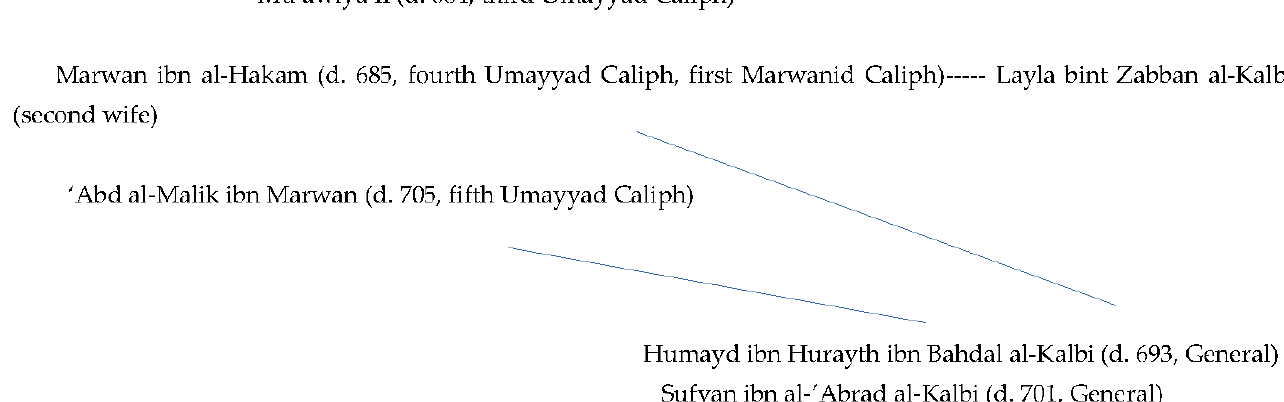
Figure A1. Umayyad-Kalbite (seventh century).